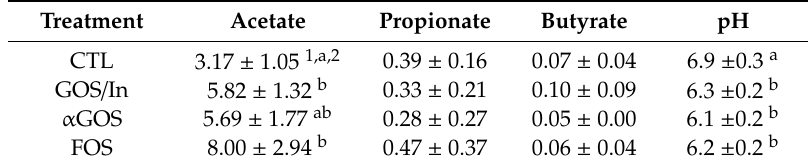
Table 4. Concentration (mM) of major short chain fatty acids (SCFA) in cecocolonic contents at PND 14 /